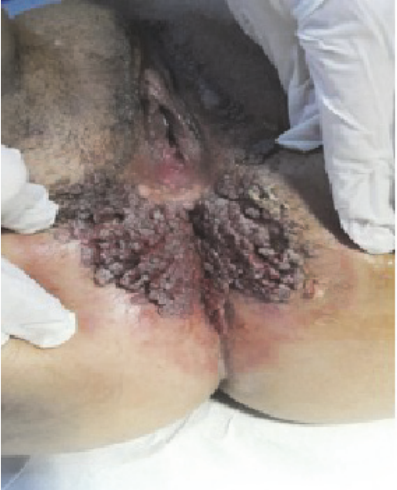
Figure 5: The appearance of Case 2 with main involvement of the anal region.